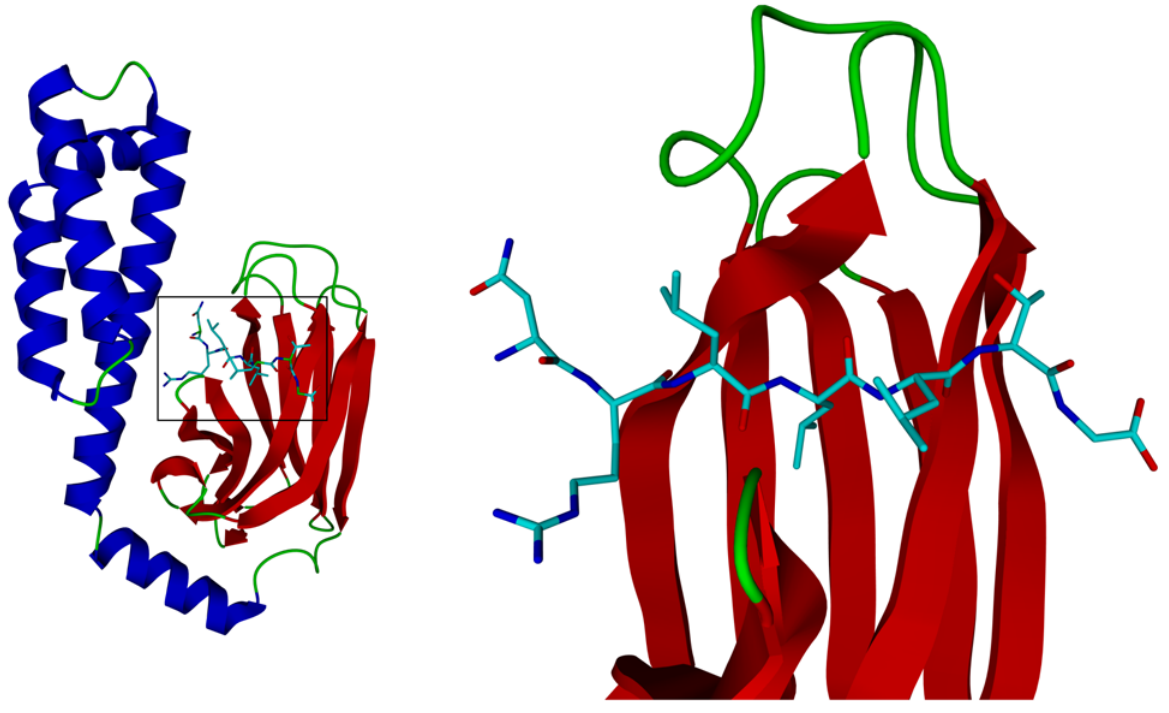
Figure 2. DnaK bound to a substrate peptide. Left: Substrate binding C-terminal domain of DnaK shown in cartoon style with bound heptapeptide NRLLLTG in stick style. Right: Detailed view of substrate binding in the beta sheet sandwich of DnaK. Molecular graphics created with YASARA (http://www.yasara.org) and Povray (http://www.povray.org).